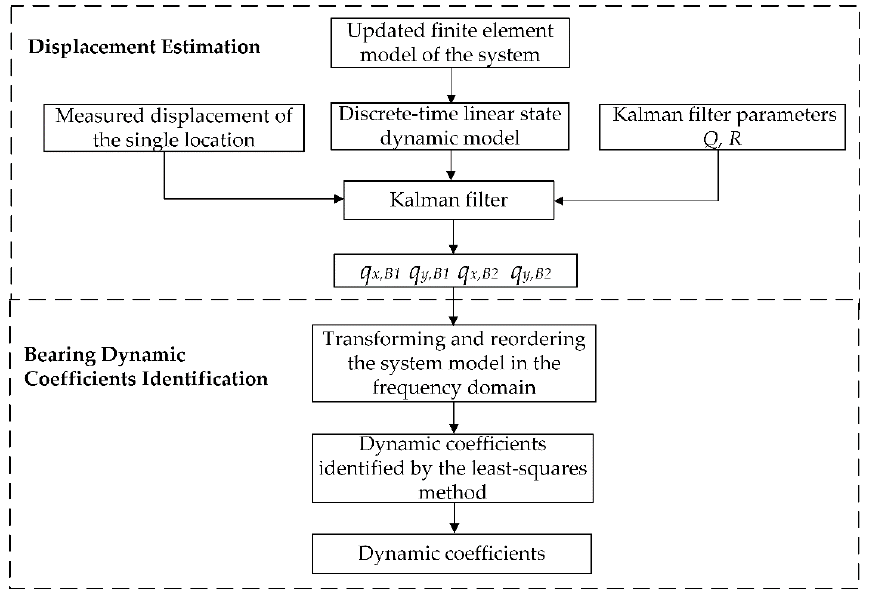
Figure 3. Theoretical mode shapes of the shaft with discs. Table 2. Measured and theoretical (initial, updated) modal frequencies.